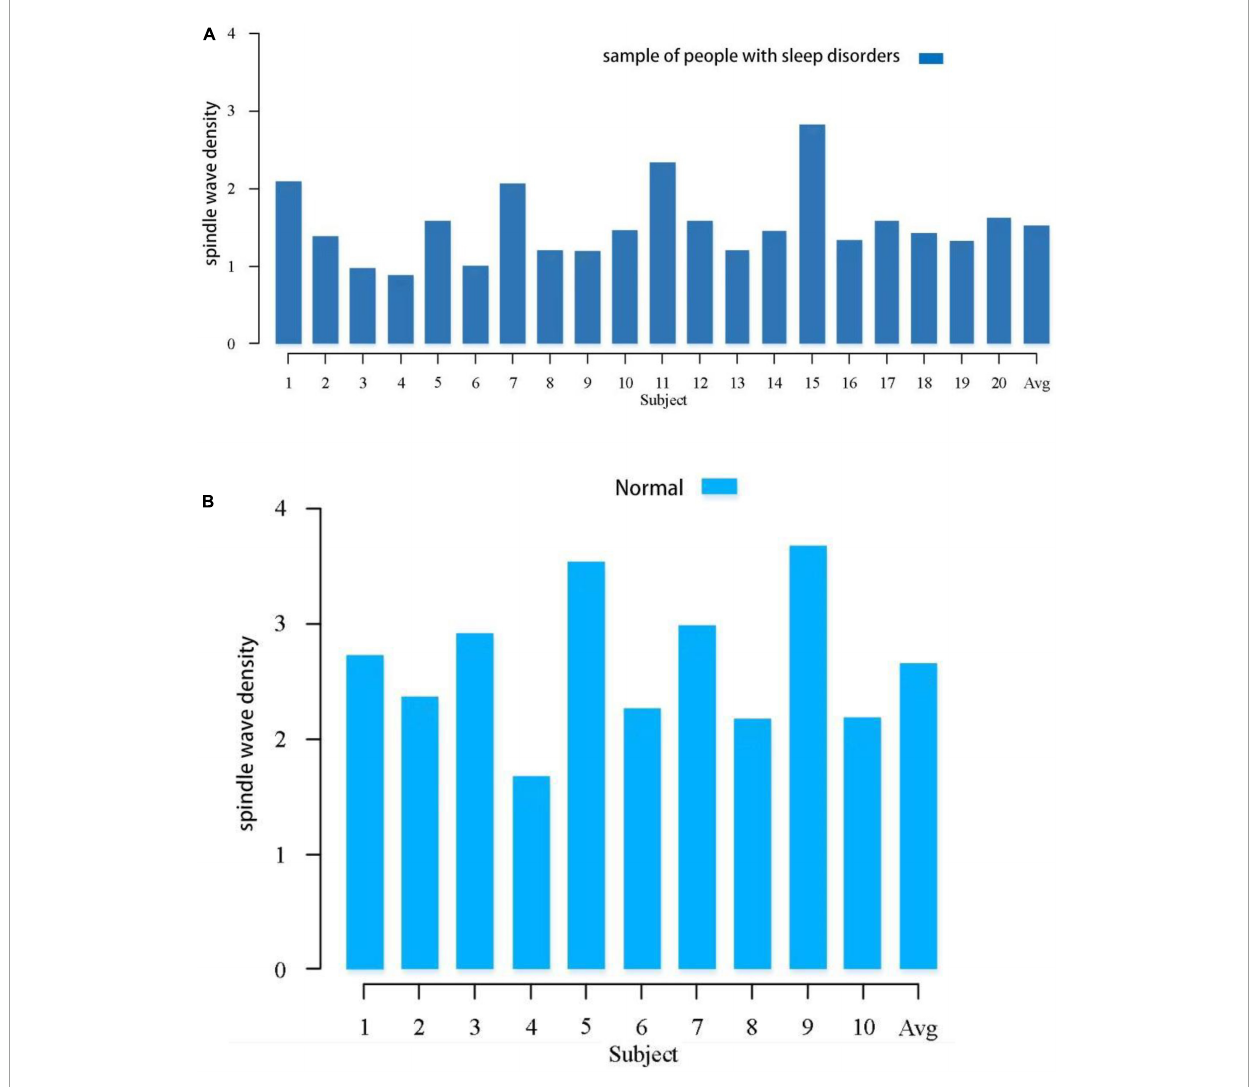
FIGURE1 Comparison of spindle density between the sleep-disordered population and the normal population during the whole night sleep. (A) Spindle wave density in people with sleep disorders. (B) Spindle wave density in normal population.